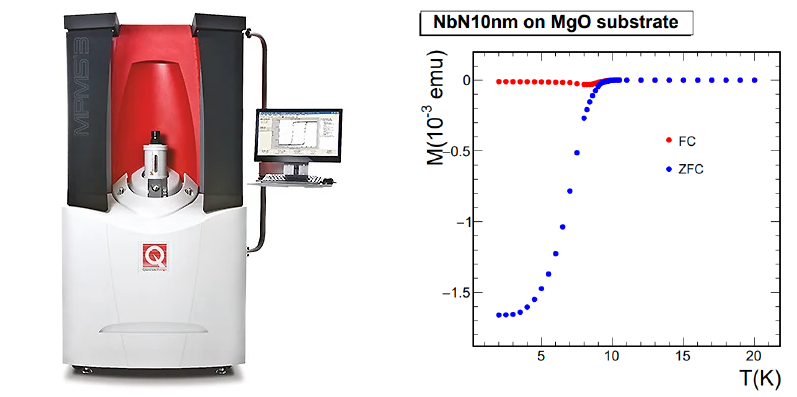
Figure 14. MPMS3 SQUID magnetometer.